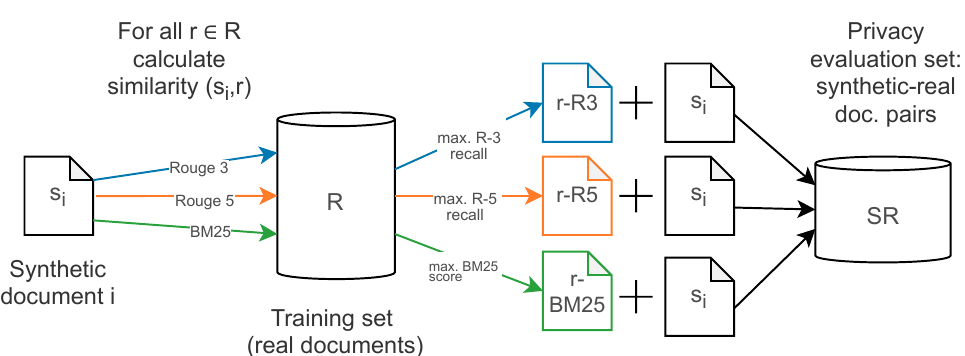
Figure 4. Illustration of method used to compile a set of similar synthetic-real document pairs for the privacy evaluation. For each synthetic document, we retrieve the most similar source documents from the real data, based on ROUGE n-gram overlap and BM25. The set SR contains the pooled result of this matching process, such that each synthetic document appears in three separate pairings: once with the top ROUGE-3 match, once with the top ROUGE-5 match and once with the top BM25